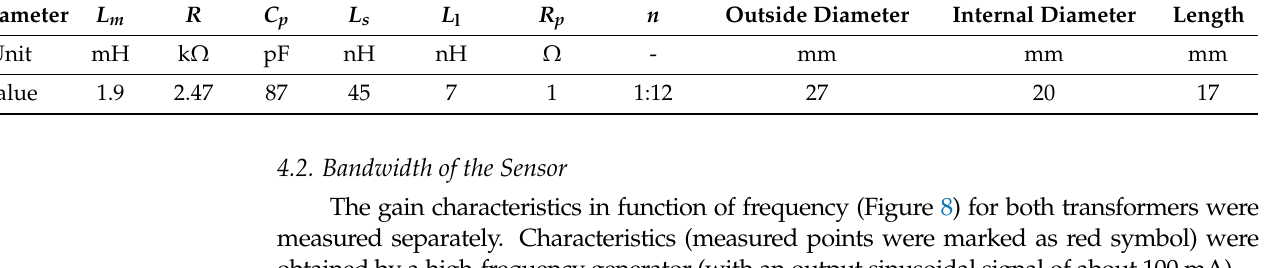
To verify the Bode plots, the − 3 dB value for the cascaded HFCT sensor was con- firmed in the next section based on the time response.